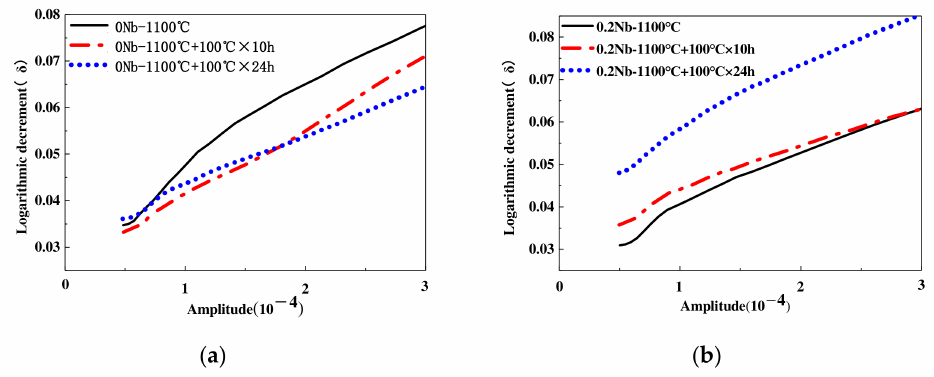
Figure 2. Damping performance of two alloy specimens aged at 100 ◦ C at different times. ( a ) 0 Nb in 1100 ◦ C; ( b ) 0.2 Nb in 1100 ◦